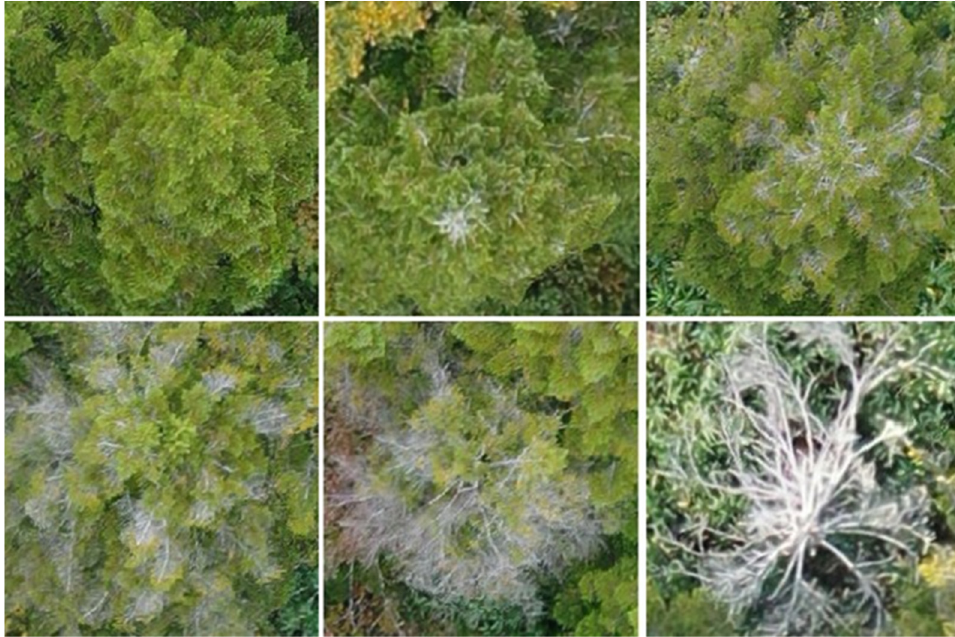
Figure 2. Different stages of defoliation. from healthy ( top left ) to dead ( bottom right ). Thus, the canopy area of each tree is divided into pixels of 0.02 × 0.02 m size each, of which the white pixels represent the defoliated branches in each tree. The proportion of white pixels to the total number of pixels (white and non-white) within the tree canopy is calculated and classified into six different categories, representing the degree of defolia- tion of any given tree: Cat 1: <2.5% (healthy, no defoliation); Cat 2: 2.5–10% (very low defoliation); Cat 3: 10–25% (low defoliation); Cat 4: 25–50% (medium defoliation); Cat 5: 50–75% (high defoliation), and finally Cat 6: >75% (dead), based on the classification of [15]. 2.5. Calculation of Whiteness The whiteness of each pixel is defined by the RGB-color system and its values. The color white consists of an equal proportion of the colors red, green and blue, with rela- tively high color values. As these values decrease, keeping the same ratio among them, the white changes to gray and then to black. However, depending on the light conditions during the collection of the images that were used for the different orthomosaics, the val- ues and ratios for the white color varies considerably. Thus, in order to determine white and non-white pixels within the tree canopy, we carried out the following three steps: First, a pixel is considered white if the red (R) and blue (B) pixel values are higher than the average R and B pixel values of the whole orthomosaic. By considering the aver- age value of the orthomosaic when defining white and non-white, different orthomosaics that were made with images collected under different light conditions can be compared. The ratio of the R and B values is used, because from successive tests, it was found that blue is the decisive value when the pixel is white. When the color value approaches white, the blue value increases and reaches similar values as the red values. Since each orthomosaic has different light characteristics, the average R and B values are different for each of the 19 orthomosaics. In the orthomosaics used in this study, the average R and B values ranged from 100 to 180 (Figure 3). Thus, for each orthomosaic, the threshold values were different. Since, after several trial-and-error tests, the threshold val- ues of the averaged R and B values left some white pixels out, we decided to homogene- ously decrease the threshold values 15 points in each orthomosaic. As a result, the model could identify clearly the white pixels in each orthomosaic regardless of the lightning con- ditions at which the images for a given orthomosaic were collected.